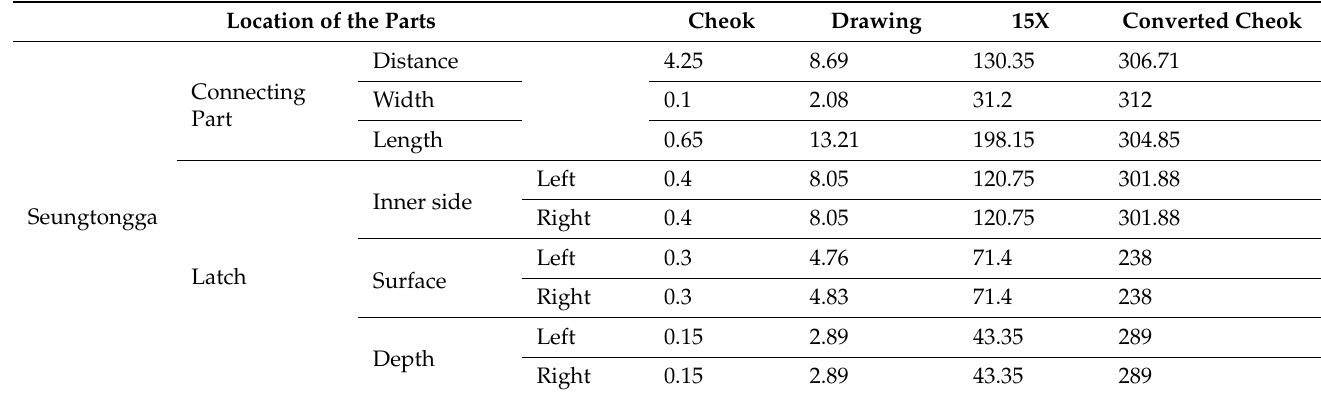
Table 3. Comparison of Seungtongga (drainage line)